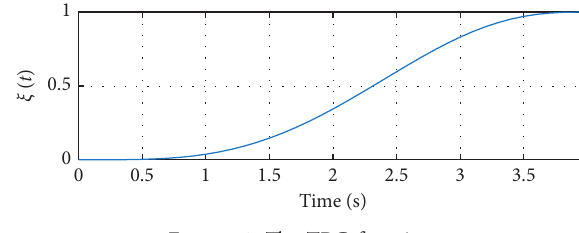
Figure 1: The TBG function.